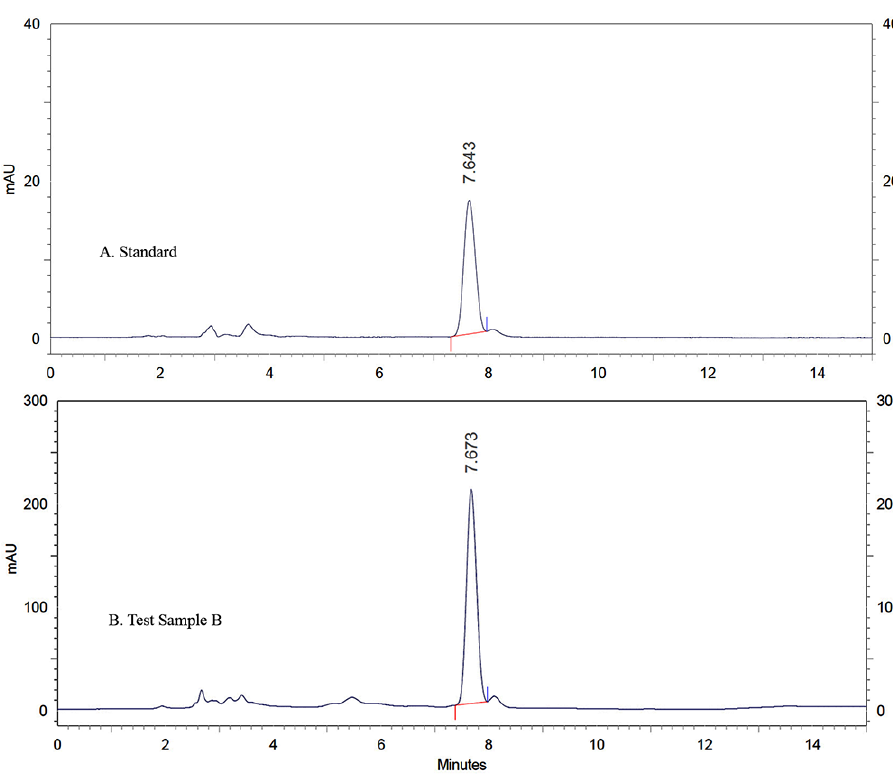
Figure 5. HPLC Chromatograph of ( A ) Standard solution ( B ) Test sample B. Table 3. Average retention area, retention time and peak height of stock solution. Table 4. Concentration reduction and percent reduction of vitamin D on day 15 and